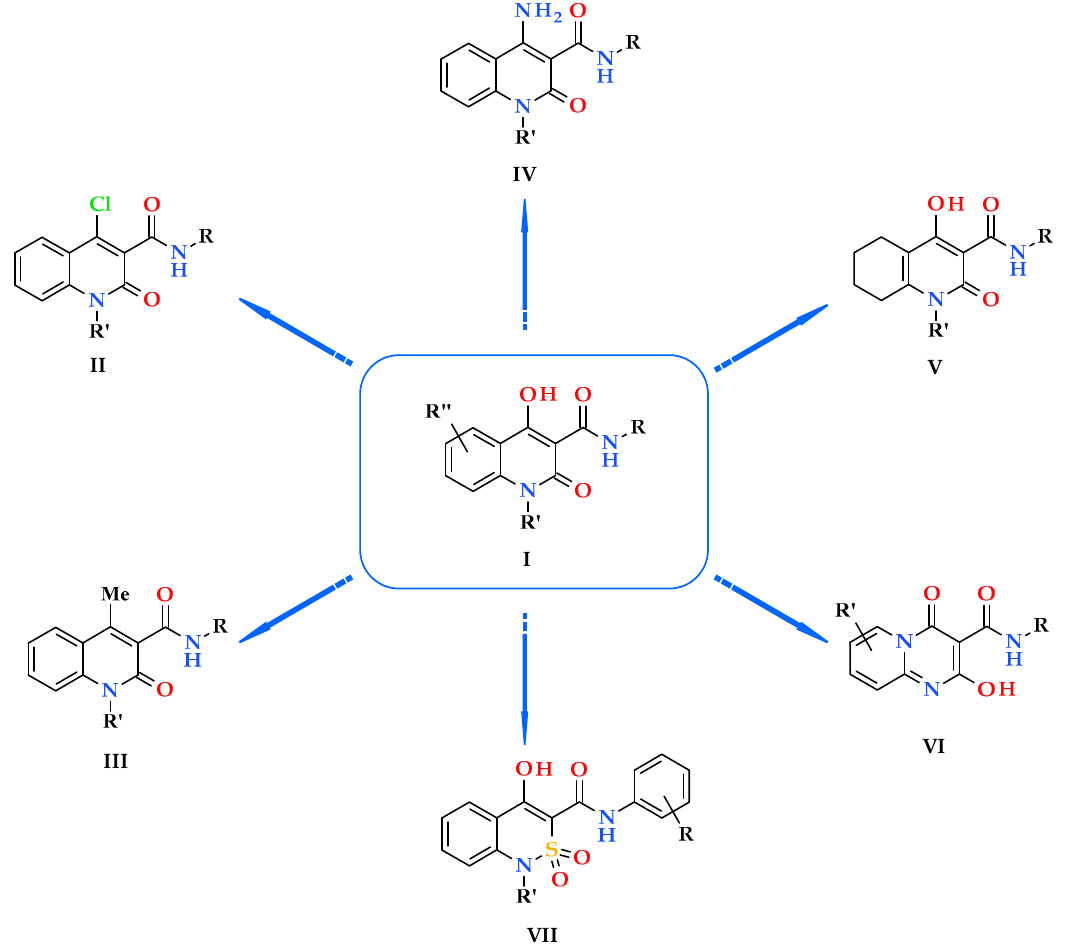
Figure 2. 4-Hydroxyquinoline-2-one diuretics I [11–15] and bicyclic “me-too” clones II – VII